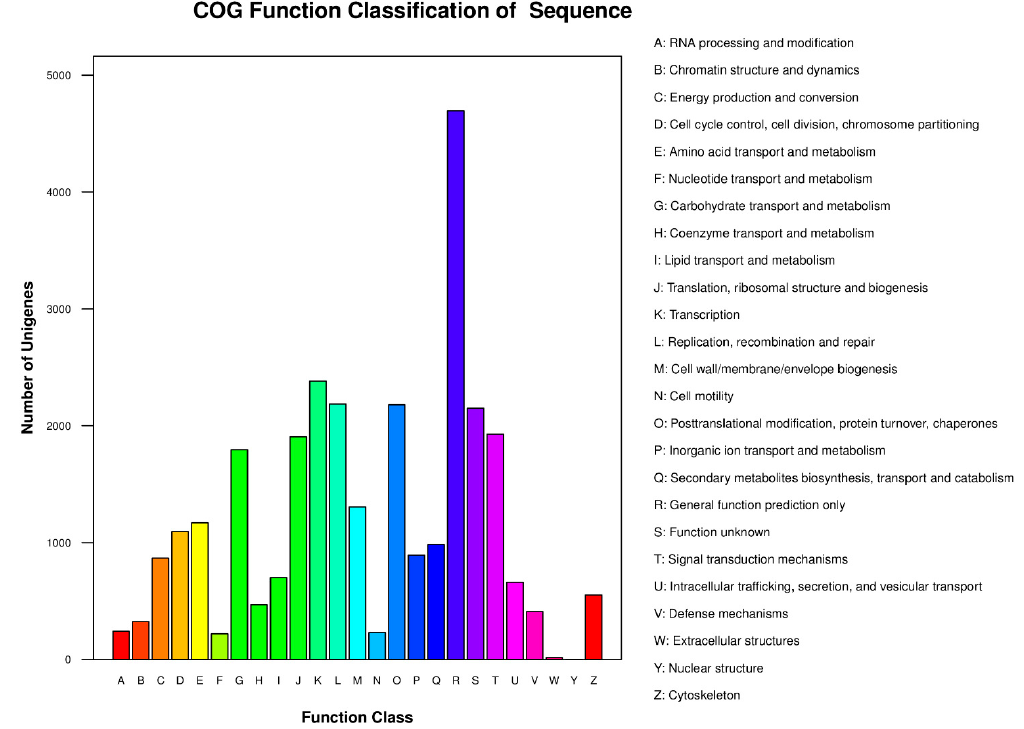
Figure 3. COG function classification of the unigenes.